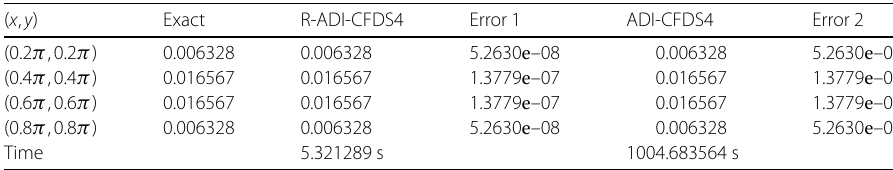
Table 14 Numerical results of SP 3 at t = 2, with h x = h y = 0.01 π , τ = 0.005 ( x , y ) Exact R-ADI-CFDS4 Error 1 ADI-CFDS4 Error 2 (0.2 π ,0.2 π )